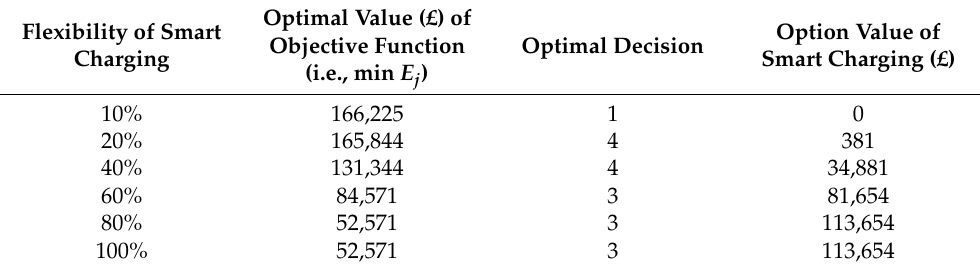
Table 3. Sensitivity analysis on the flexibility of Smart Charging of EV using BIF. Flexibility of